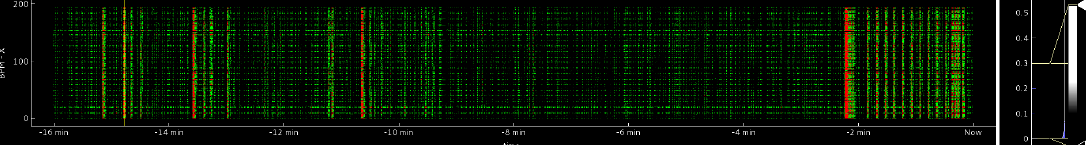
Figure 4. BPM trends in the horizontal plane for the 3 GeV storage ring. The vertical axis displays the BPM number, while the horizontal axis displays the time (in minutes). The vertical red lines are due undulator gap movements from a beamline. At these instants, the fluctuation of the beam position surpassed the set tolerance of ± 0.3 µ m. The vertical scale on the right (in µ m) controls whether there is any deviation within the lower and upper limits set by the scale.